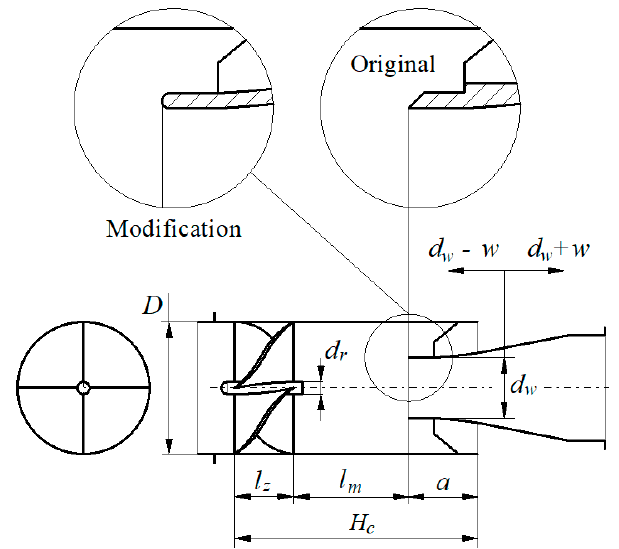
Figure 9. Diameter d w change of the cyclone outlet tube from its original value and applying the streamlined inlet shape of the outlet tube.